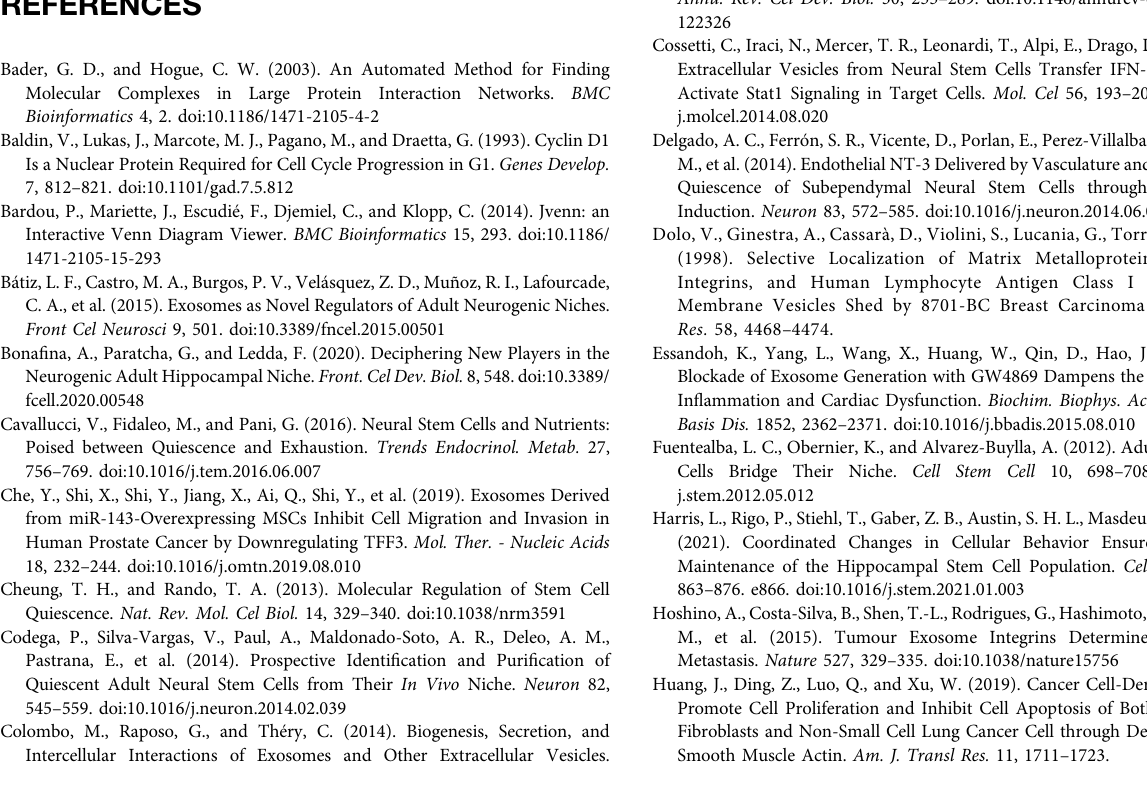
Supplementary Table S1 | Proteins identi fi ed using proteomic analysis.